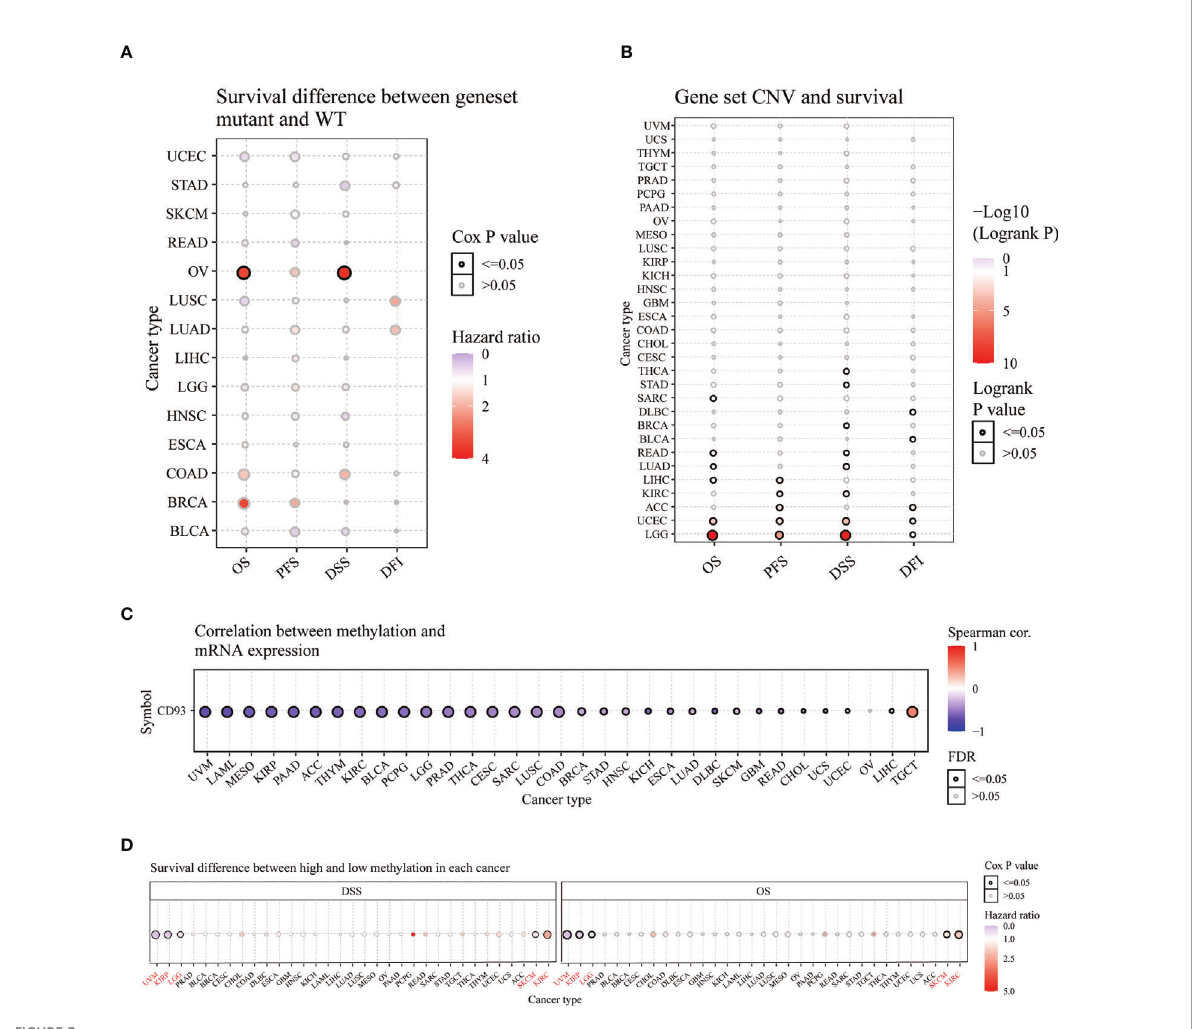
FIGURE 3 Survival analysis of CD93 in pan-cancer from the GSCA database. Survival difference between CD93 mutant and WT (A) . CD93 CNV and survival (B) . Correlation between CD93 methylation and mRNA expression (C) . Survival difference between CD93 high and low methylation (D)